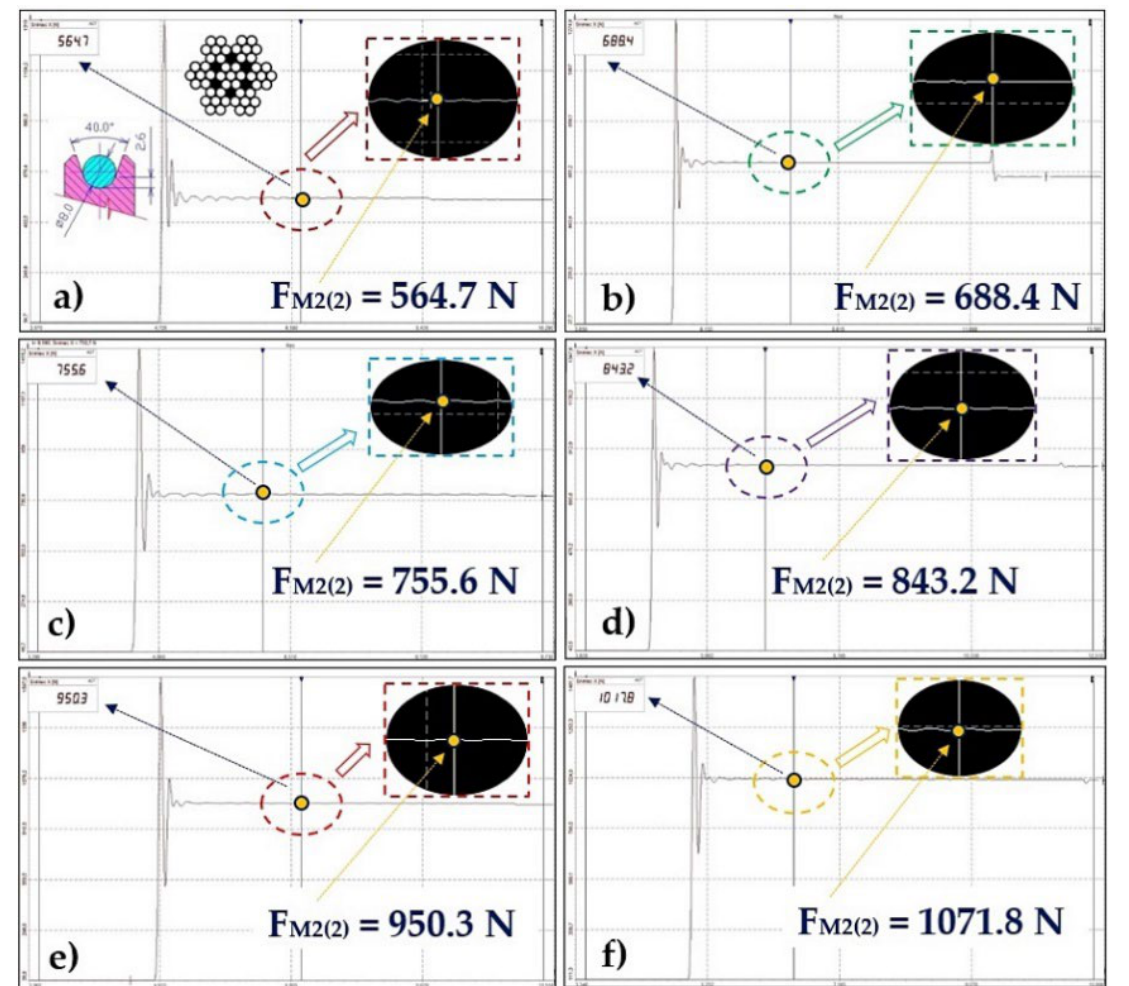
Figure 5. Measurement of tensile forces F M2(i) [N] for φ 8 mm rope, semi-circular groove, clean condition (for weight of weights G z [N] ( a ) 49 N, ( b ) 98 N, ( c ) 147 N, ( d ) 196 N, ( e ) 245 N, ( f ) 294 N). Table 4. Tensile force F M2(i) [N] for i = 6 ÷ 10, φ 8 mm rope, semi-circular groove, clean